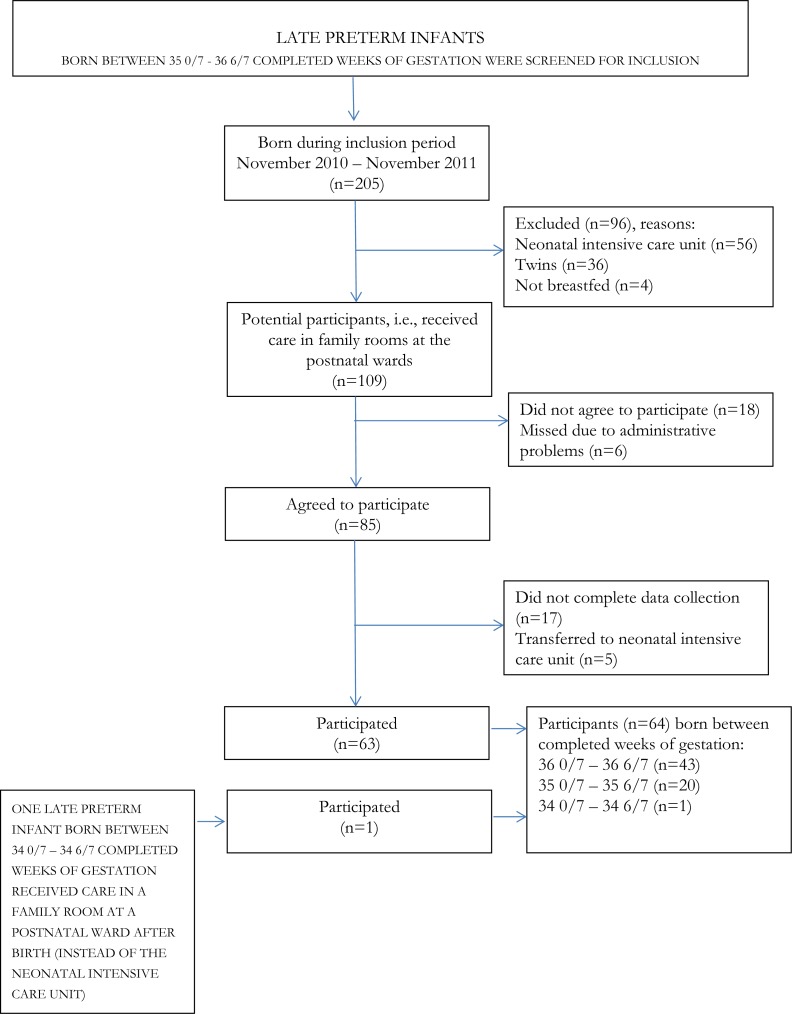
Numbers of potential participants, participants, reasons for exclusion and attrition.